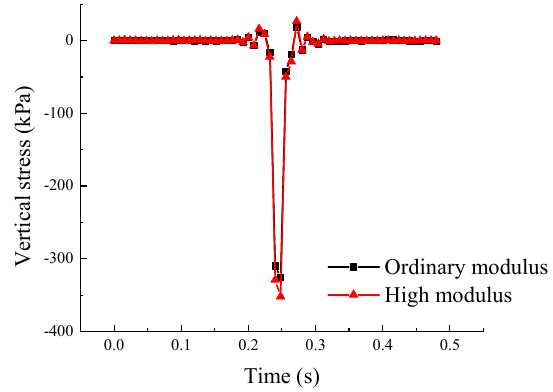
Figure 3. Comparison of vertical stress in the upper surface layer.